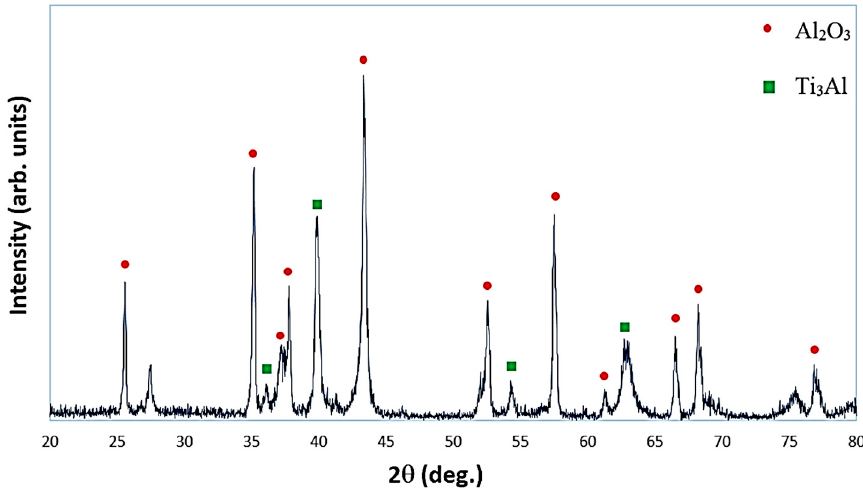
Figure 3. X-ray diffraction patterns of reacted sample after sintering at 850